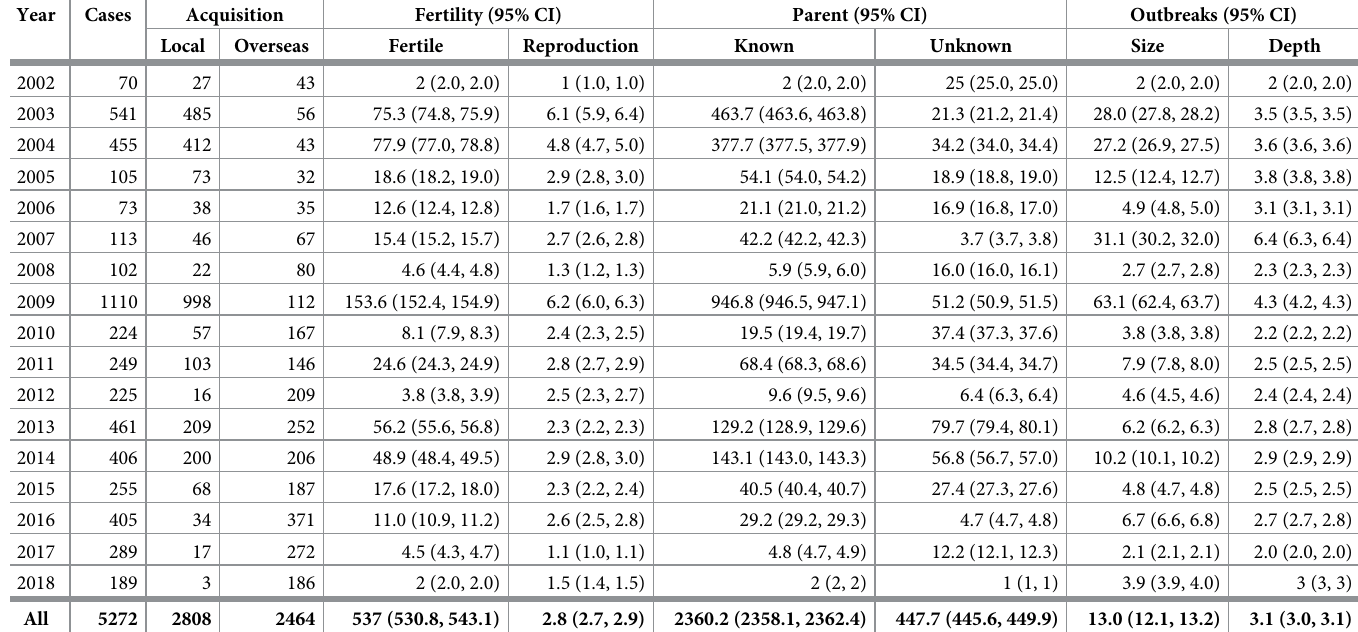
Table 1. Statistics on dengue occurrence and dynamics of its spread in Queensland, Australia. The Fertility, Parent and Outbreak columns present the average (value outside the parentheses) and confidence interval values that were computed by applying the Monte Carlo’s method to the construction of the disease spread network. A case is fertile if it has resulted in at least one secondary case and the reproduction indicates the average number of secondary cases per fertile case. The parent of a locally acquired case is unknown if no suitable parent case was found during the construction of the disease spread network and known otherwise.An outbreak is a set of cases connected by the chain of infections (through parent child relations). The size of an outbreak denotes the number of cases in an outbreak. Let the first case of an outbreak be called root. An outbreak generation is a set of cases that are at the same distance (by number of parent child relations) from root. The number of generations in an out- break are called the depth of the